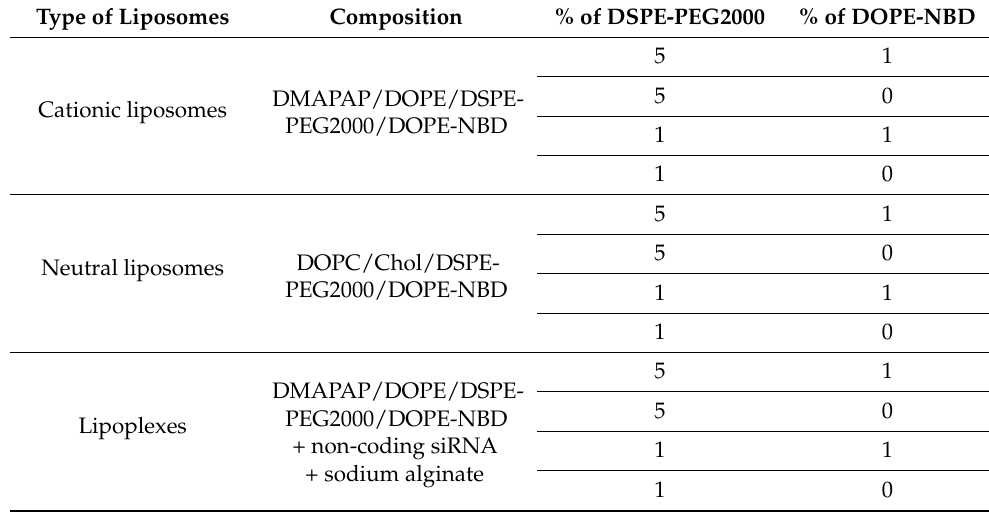
Table 3. Composition of liposomes and lipoplexes included in the